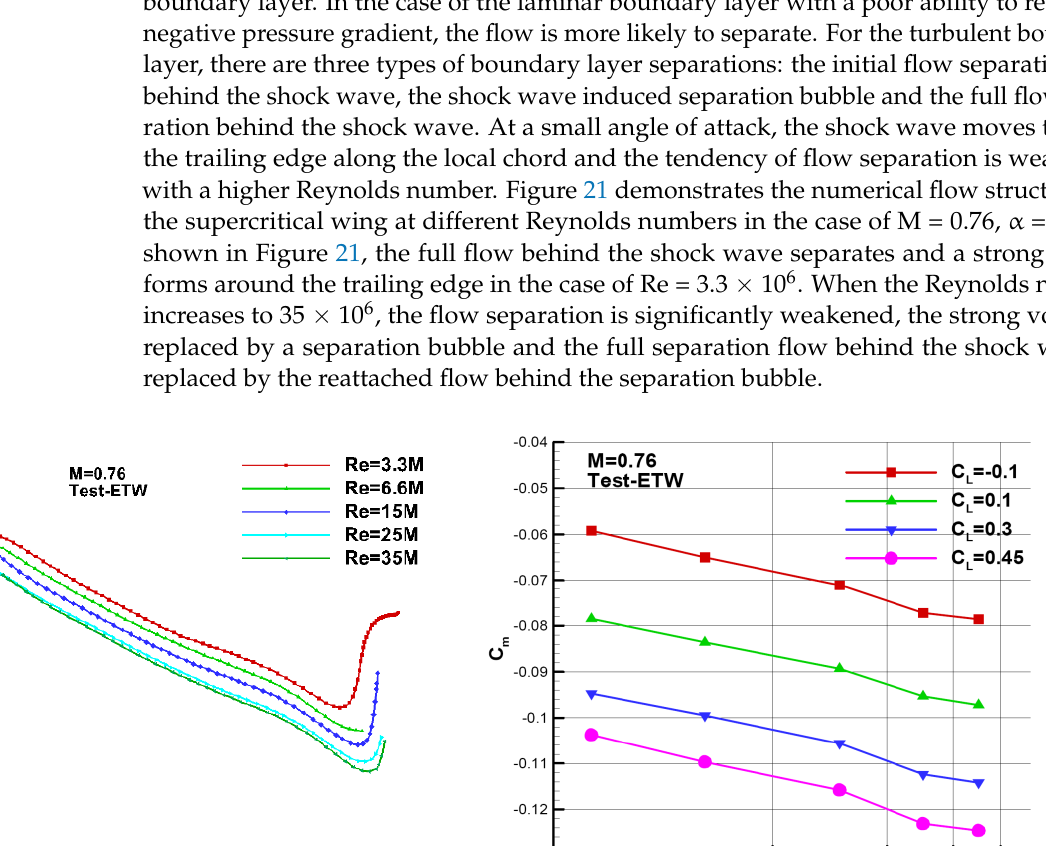
Figure 18. Typical lift coefficient curves at different Reynolds numbers: ( a ) M = 0.76; ( b ) M = 0.79.